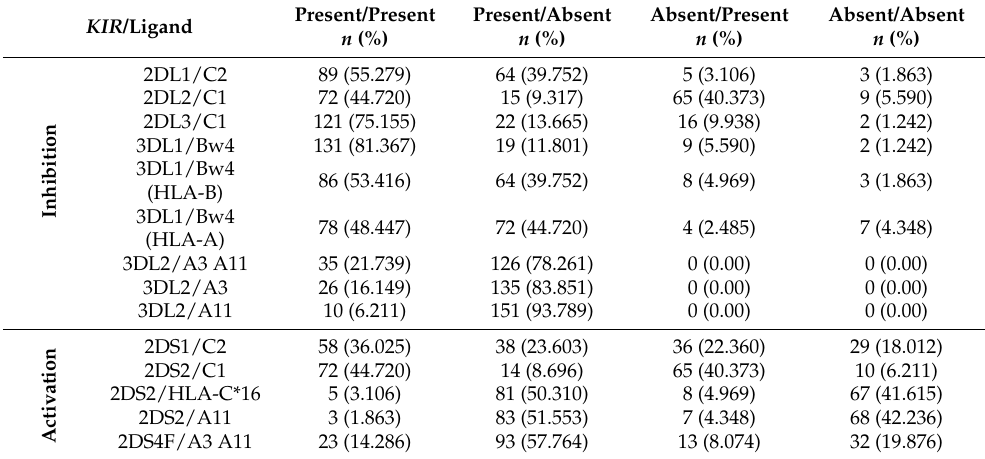
Figure 1. HLA allotype frequencies. Percentage and number of individuals carrying KIR ligands. Table 3. KIR –HLA combinations.